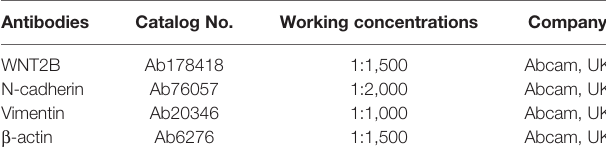
TABLE 2 | The information for the primary antibodies in Western Blot analysis. Antibodies Catalog